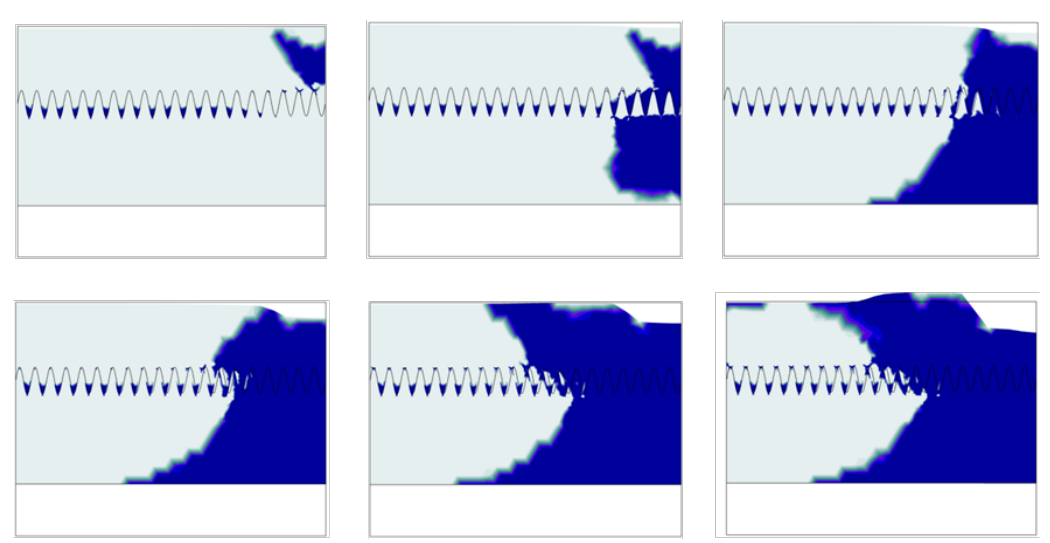
Figure 9. Variation of the distribution of the plastic zone of the foundation with the upper load.